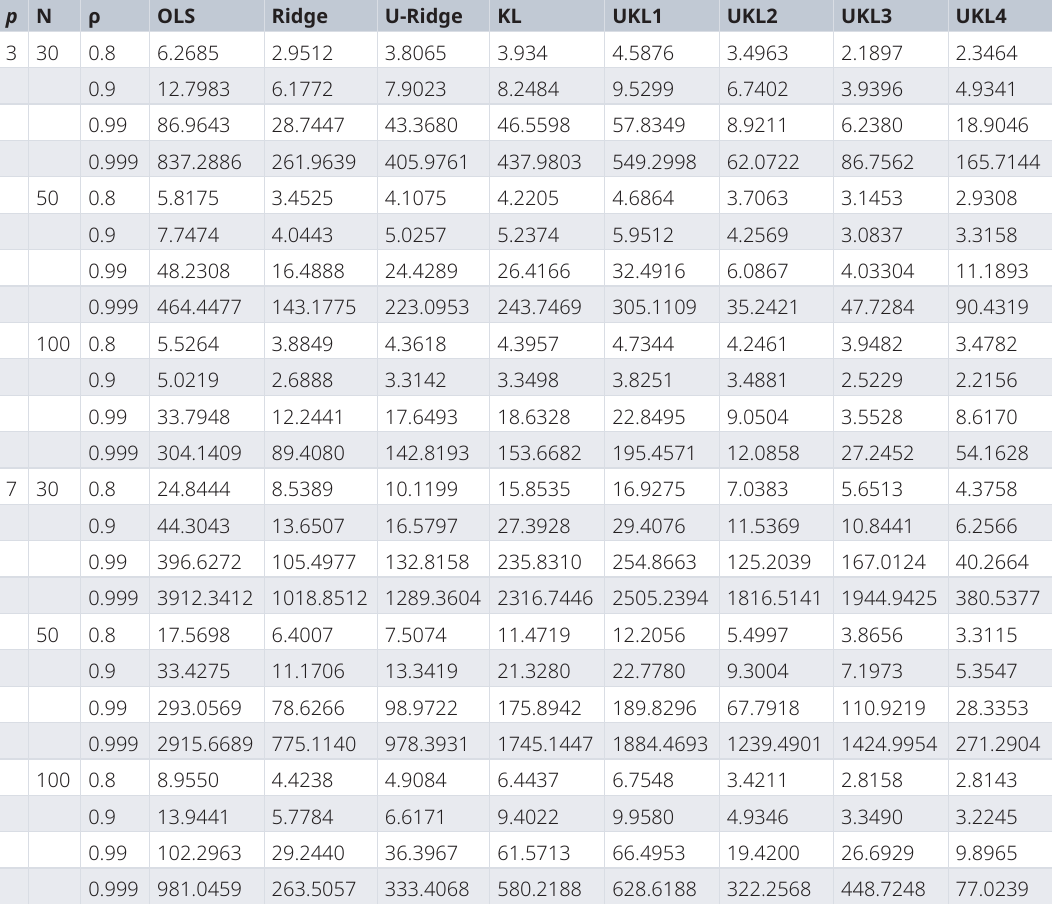
Table 2. Estimated MSE for the simulation study when